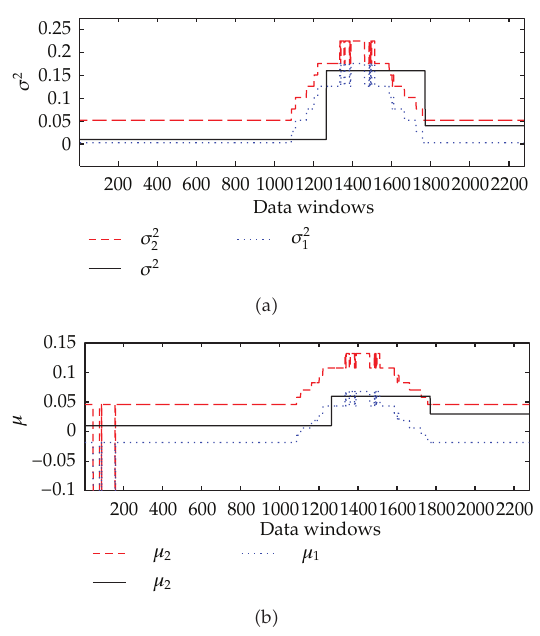
Figure 2: The parameters σ 2 and μ , reconstructed from the synthetic data.